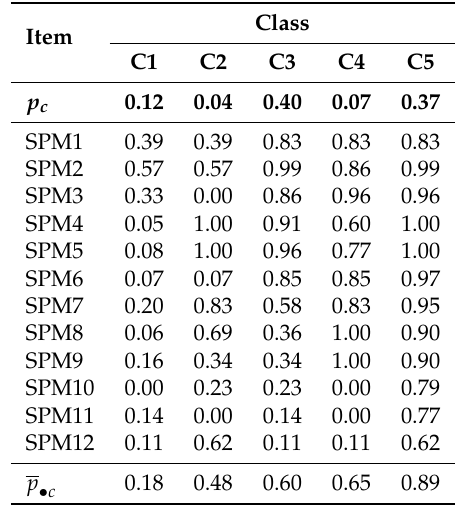
Table 11. SPM-LS dichotomous data: estimated item probabilities and latent class probabilities for best fitting RLCM with C = 5 latent